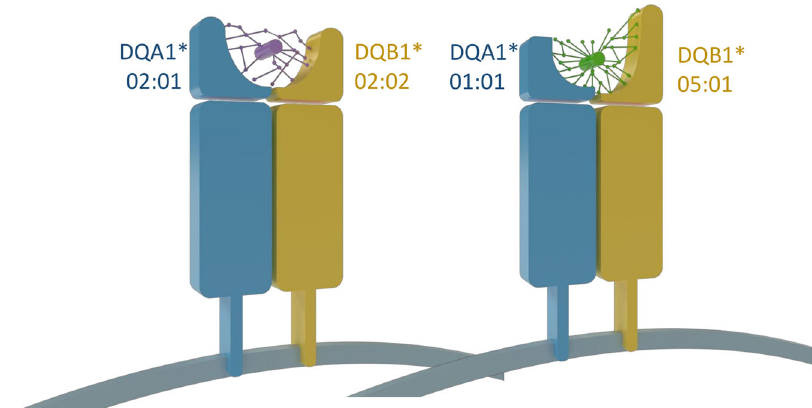
Fig. 3 MHC structures and peptide presentation. The HLA-DQ molecule is an αβ heterodimer of MHC class type II. The three-dimensional shape of the peptide-binding groove is formed by the combination of α and β chains, which are genetically encoded by the HLA-DQA1 and HLA-DQB1 alleles respectively 81 . The structure of the peptide-binding groove determines which peptides (foreign or self) are presented at the cell ’ s surface 81 , as is shown in the schematic. As an example, in coeliac disease, patients possess HLA alleles that encode for peptide binding grooves with structures suited to the presentation of gluten-derived peptides